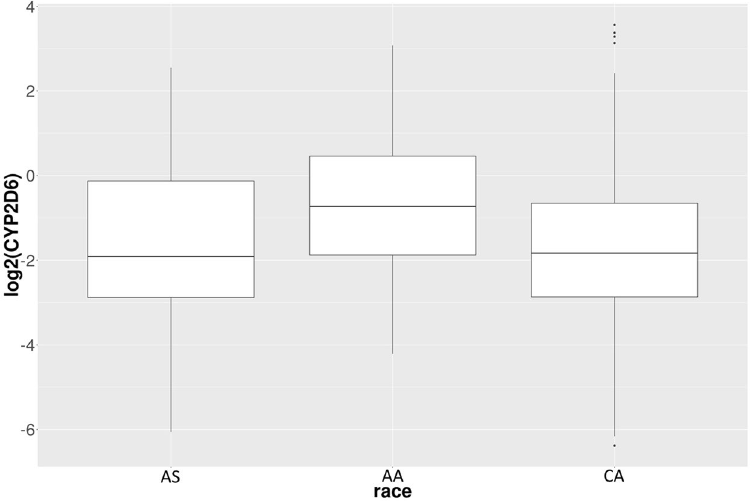
Figure 2. Expression of CYP2D6 in Asian American (AS), African American (AA), and Caucasian American (CA) breast cancer tissues. Y-axis is log2 of normalized expression values (in reads per million). The p-value for AA vs. AS comparison is 0.075, and the p-value for CA vs. AA comparison is 1.27e-06. The reason that the latter has much smaller p-value is because the sample sizes of AA and CA are much larger than that of